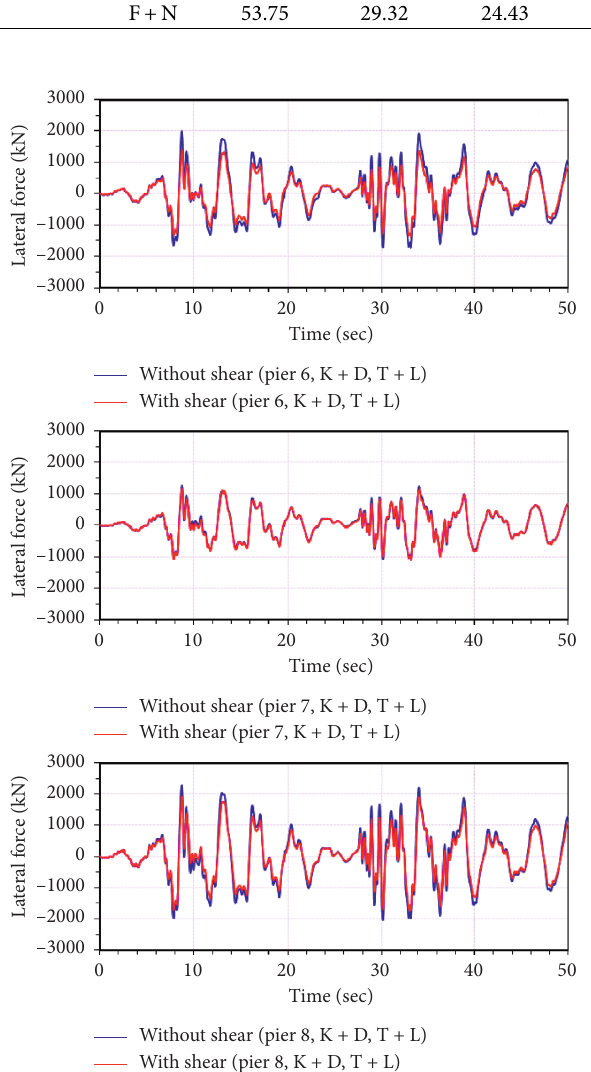
Figure 14: Transverse lateral force response without and with shear subjected to biaxial input ground motions of multiple earthquakes,